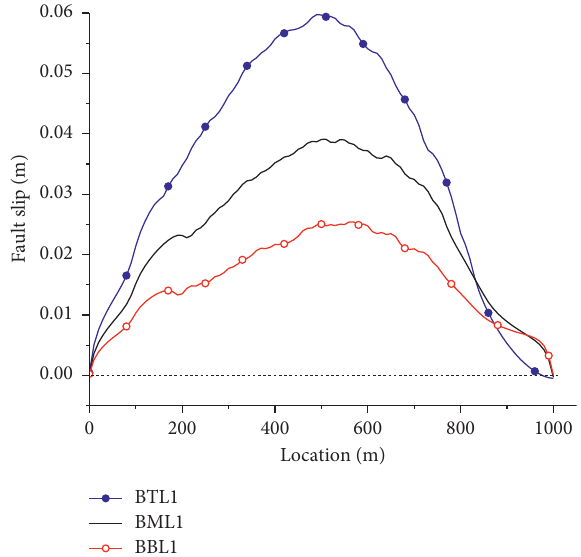
Figure 17: Fault slip along the fault plane when the fracturing region was BTL1, BML1, or BBL1.